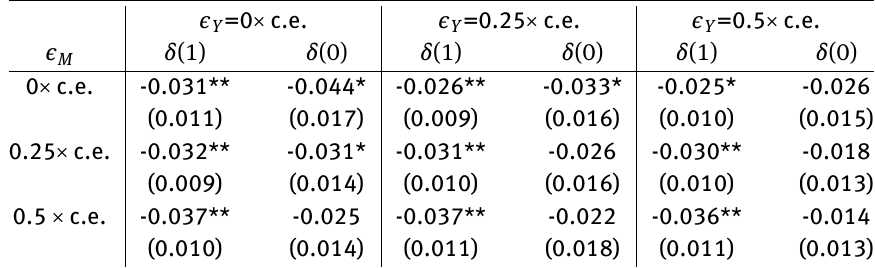
Table 3: Sensitivity of estimates with the deviation from the ER ϵ Y =0 × c.e. ϵ Y =0.25 × c.e. ϵ Y =0.5 × c.e. ϵ M δ (1) δ (0) δ (1) δ (0) δ (1) δ (0) 0 × c.e.